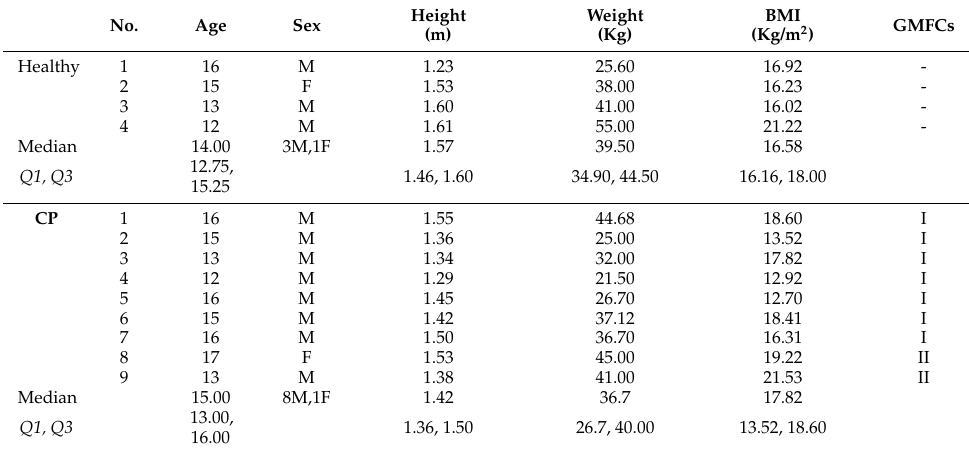
Table 1. Demographics of cerebral palsy and healthy subjects.